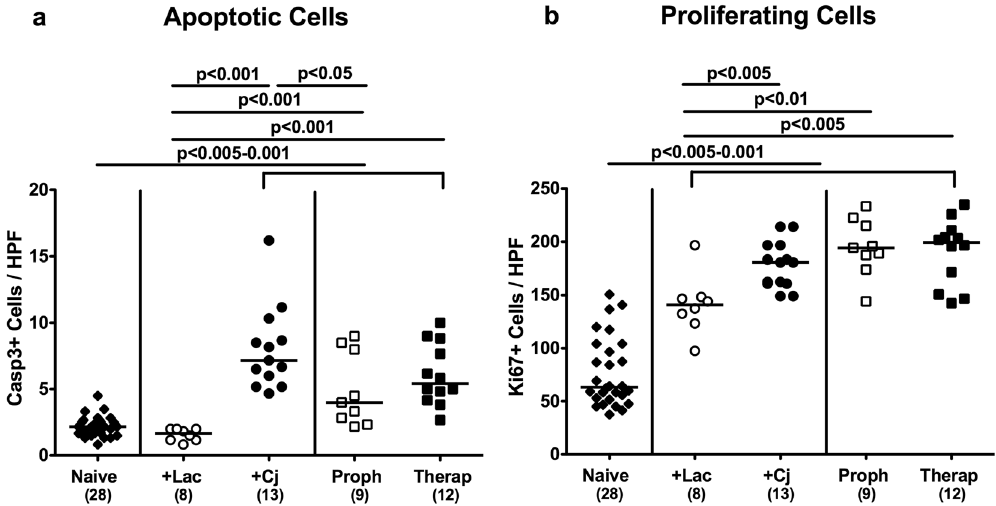
Figure 2. Apoptotic and proliferating cells in the colonic epithelium of C . jejuni strain 81–176 and/or L . johnsonii associated secondary abiotic mice. Secondary abiotic mice were perorally infected with C . jejuni strain 81–176 (Cj) and associated with L . johnsonii (Lac) either 14 days before (prophylactic regimen, Proph; white squares) or 7 days thereafter (therapeutic regimen, Therap; black squares) and compared to mono-associated mice ( + Lac, white circles; + Cj, black circles). The average number of colonic ( a ) apoptotic cells (positive for caspase-3, Casp3) and ( b ) proliferating cells (positive for Ki67) from six high power fields (HPF, 400x magnification) per animal was determined microscopically in immunohistochemically stained colonic paraffin sections at days 21 or 28 following initial C . jejuni or L . johnsonii infection, respectively. Naive mice (black diamonds) served as uninfected controls. Medians (black bars), levels of significance (p-values)